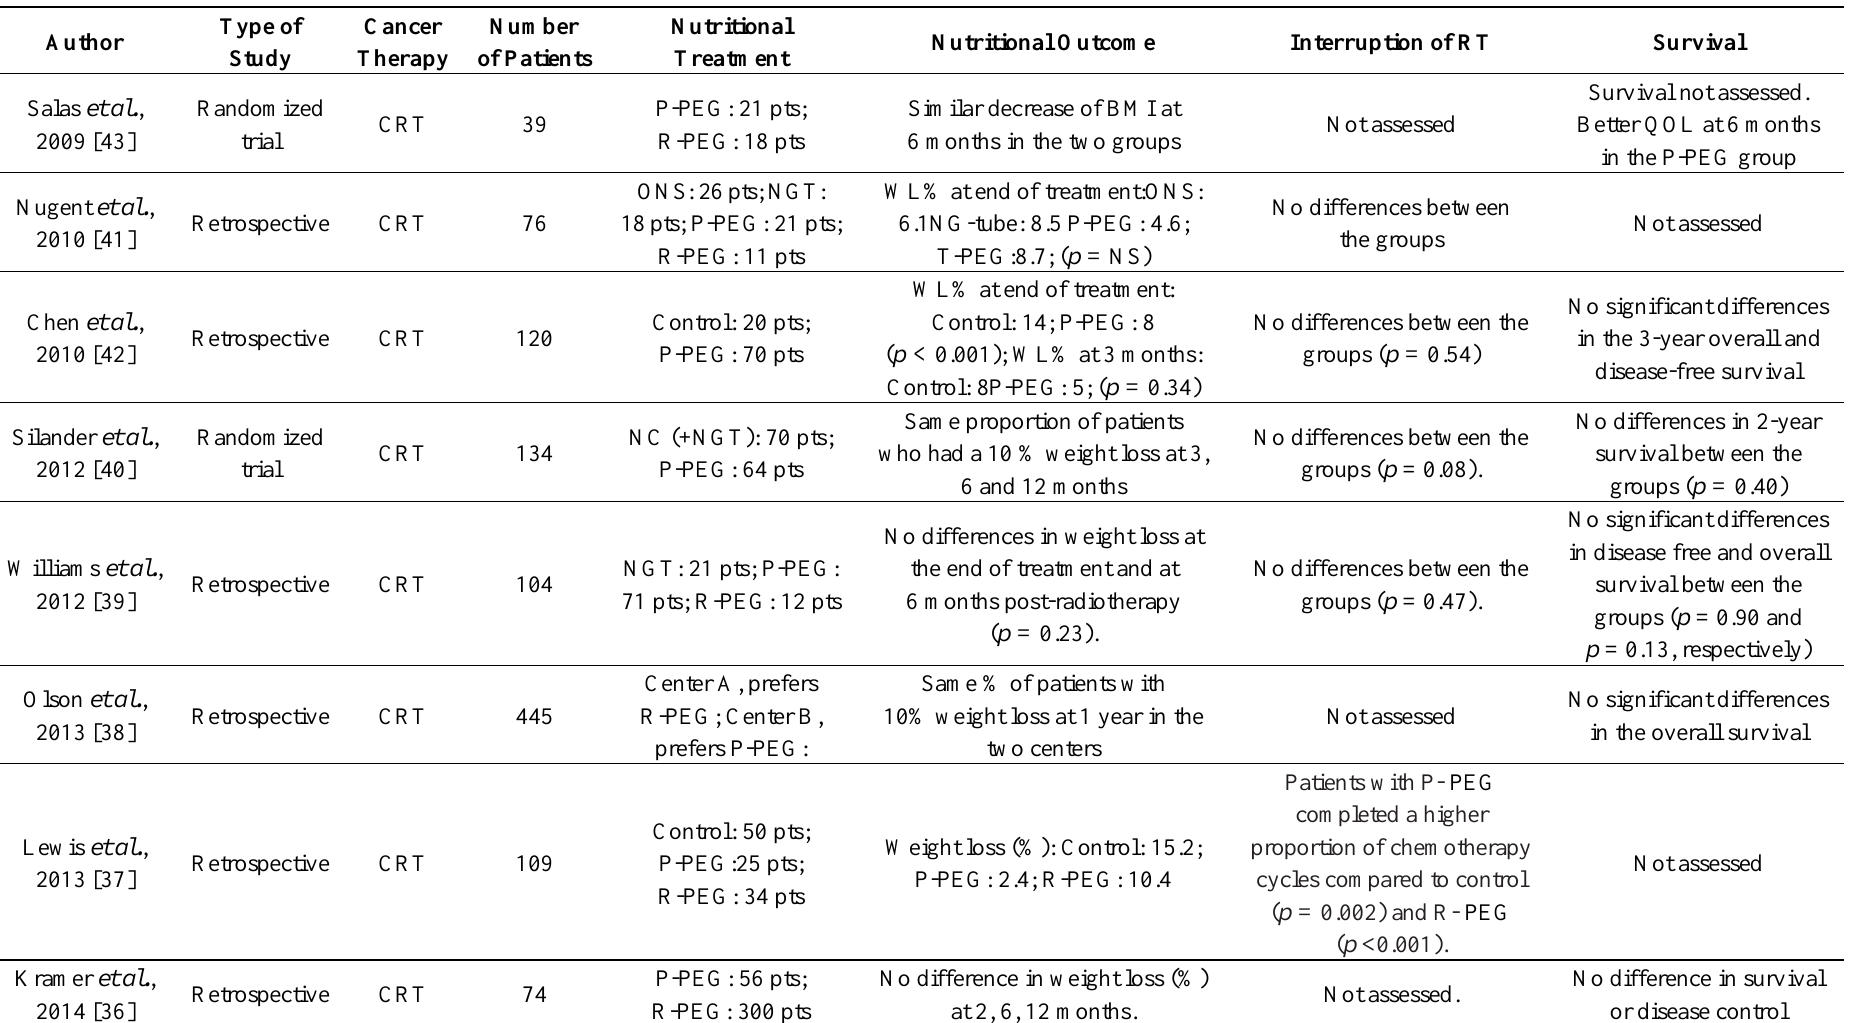
Table 3. Prophylactic feeding in head and neck cancer patients receiving chemoradiotherapy (CRT). P-PEG, prophylactic percutaneous gastrostomy; R-PEG, reactive percutaneous gastrostomy. No-FT, no feeding tube; NGT, nasogastric tube; NC, nutritional counselling; ONS, oral nutritional